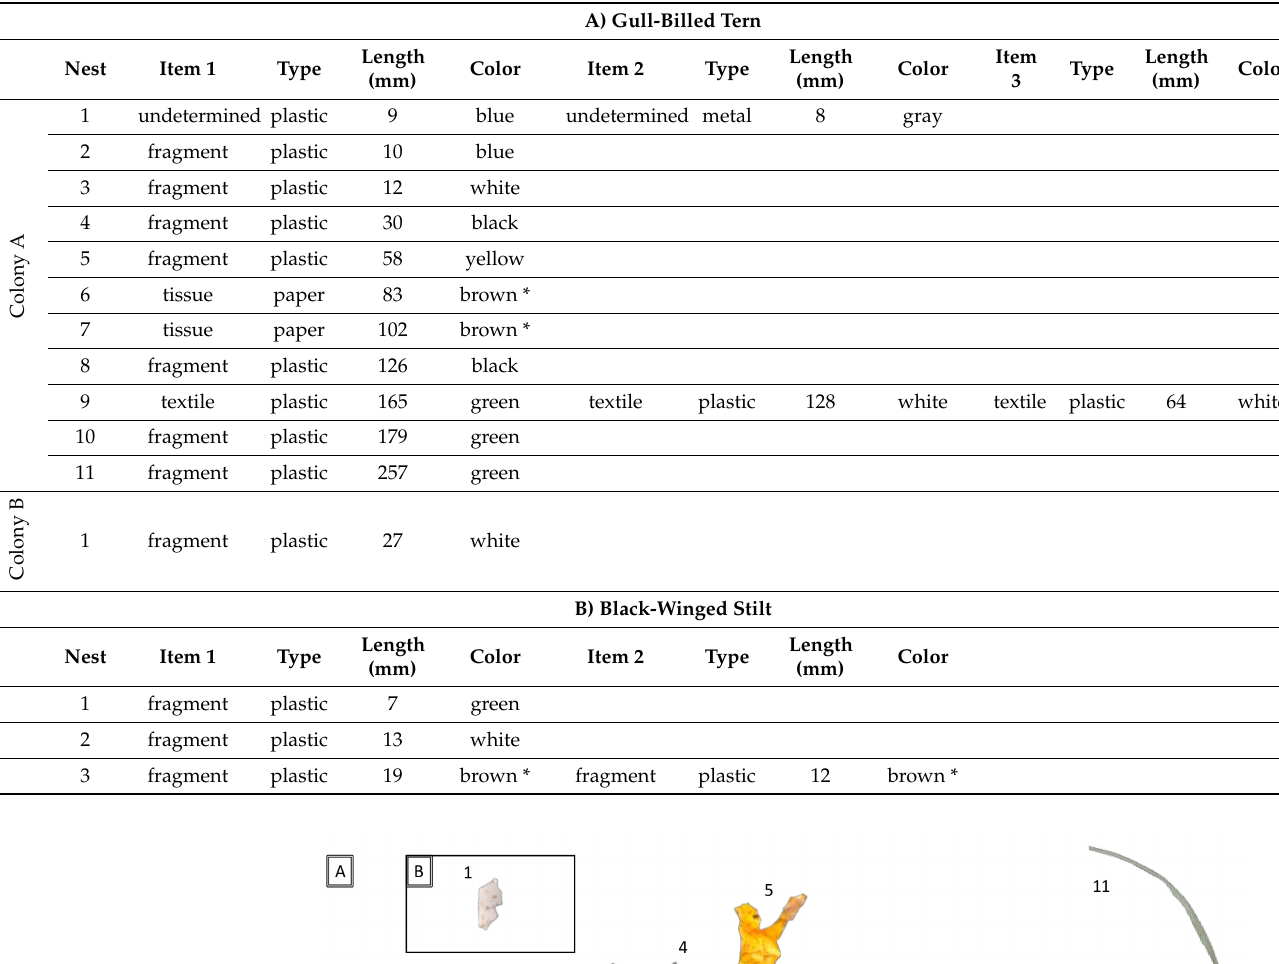
Table 1. Anthropogenic materials found in the nests of the gull-billed tern ( A ) and the black-winged stilt ( B ) ordered by fragment length, given in mm. * Plastic that was originally white but was observed to be brown due to contact with lake mud. We are not sure what color they were when the birds deposited these fragments in the nests.